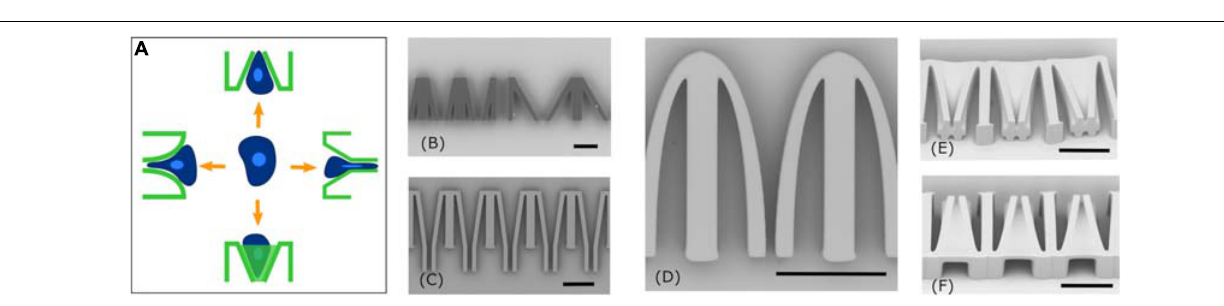
FIGURE 4 | Different constriction geometries. (A) Scheme of four possible geometries; (B) simple funnel geometry realized with angles of 12 and 30 degrees; (C) funnel geometry combined with 40 µ m long tunnels; (D) close up of single constriction with elliptical profile; (E,F) 3D funnel geometry. Scale bars corresponds to 50 µ